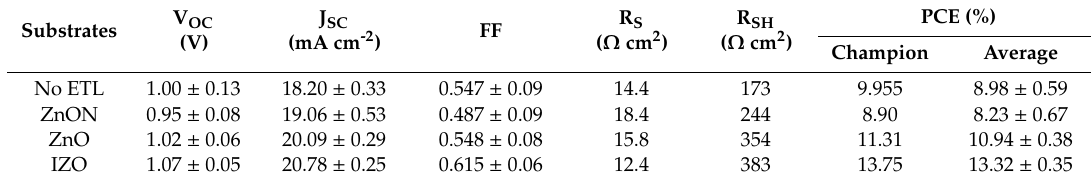
Table 1. Device parameters of the PVSCs based on metal oxide layer.